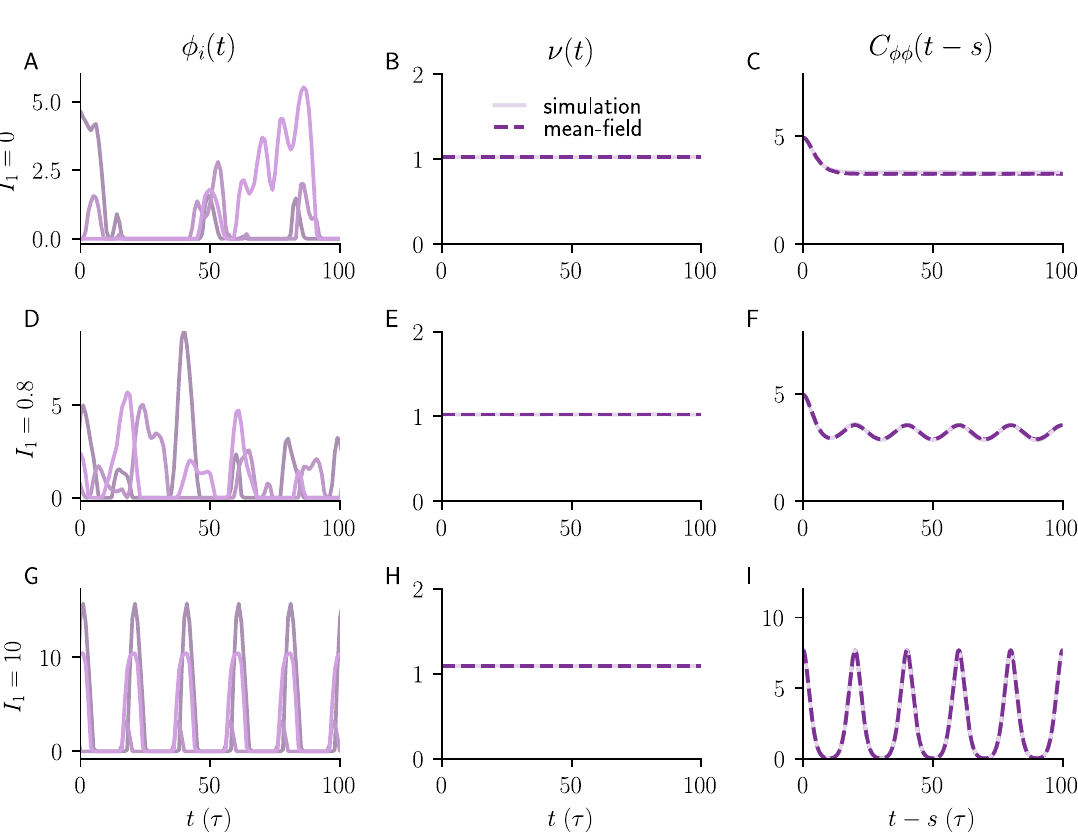
Fig 9. Activity, population firing rate and autocorrelations of balanced networks with independent input. A) Firing rates ϕ i ( t ) = ϕ ( h i ( t )) of three example units. B) Mean population firing rate ν ( t ). C) Autocorrelation function with no external input ( I 1 = 0). D)-F) Same as A-C but for input amplitude of I 1 = 0.8; activity remains chaotic. G)-I) Same as A-C but for stronger input ( I 1 = 10); activity is fully controlled by the external input and is no longer chaotic. Dashed lines (middle and right columns) are results of stationary DMFT, full lines are median across 10 network realizations. Model parameters: N = 5000, g = 2, f = 0.05/ τ , I 0 = J 0 = 1.